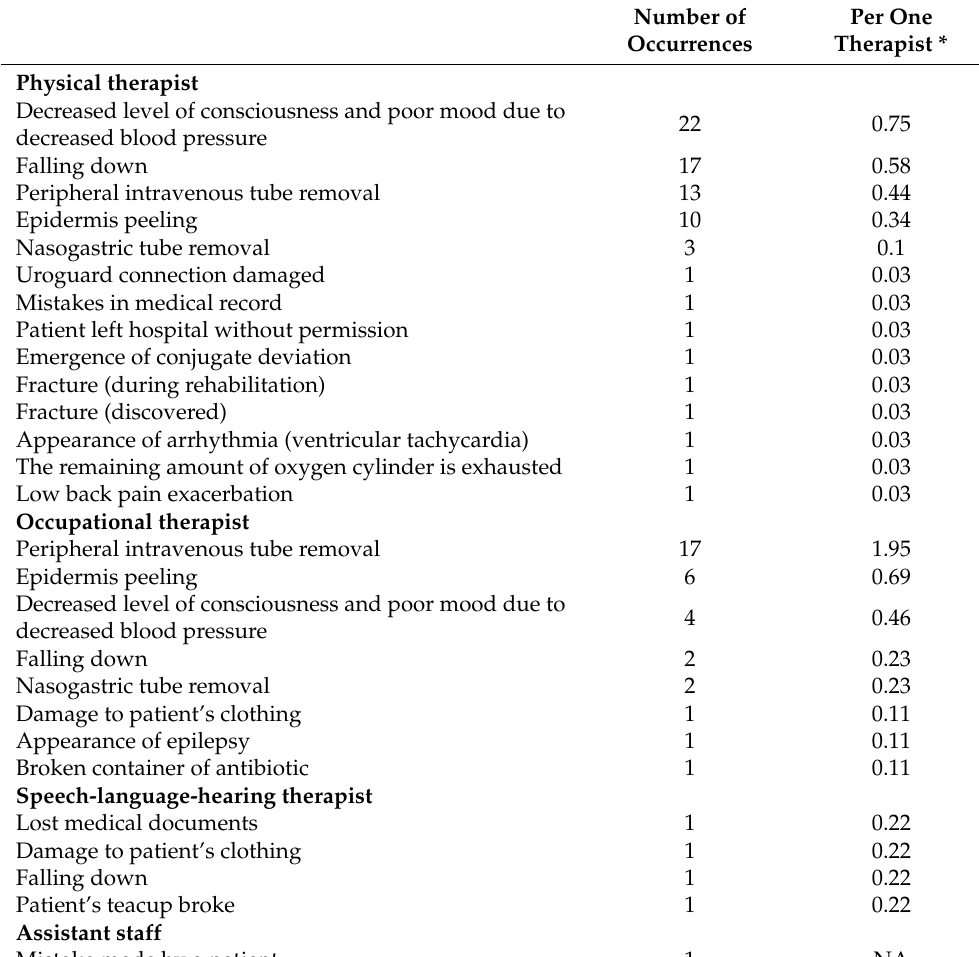
Table 2. Number of adverse events per physical therapist, occupational therapist, and speech- language-hearing